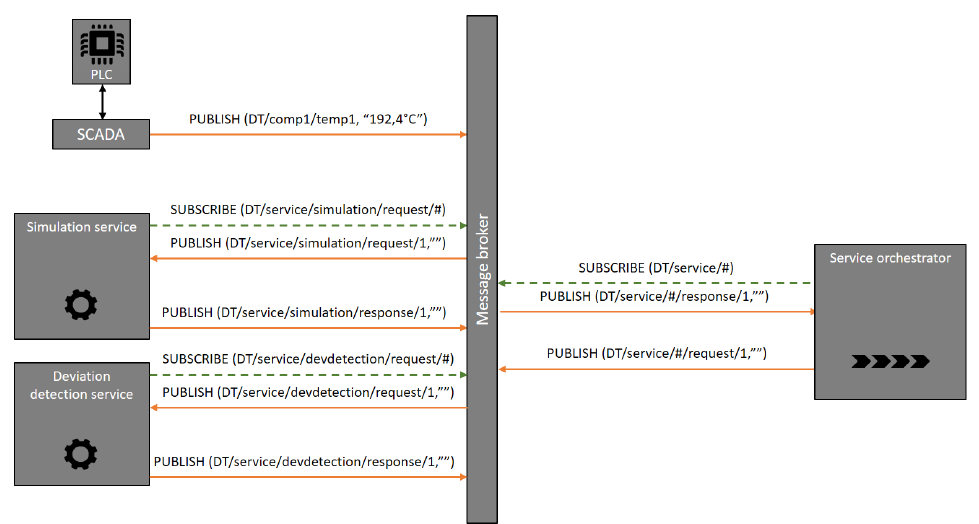
Figure 3. Exemplary request–response message pattern in the DT platform. Services subscribe to their respective request-topics and thereby receive messages published by the service orchestrator, e.g., to start operating. When a service instance has completed a run, it publishes to its response topic, which is monitored by the service orchestrator via subscription. Note: The function of the service orchestrator is explained in detail in Section 3.5. Character # denotes a multi-level wildcard, hence receives all messages of a topic that begins with the pattern before the wildcard character, and ” ” contains message